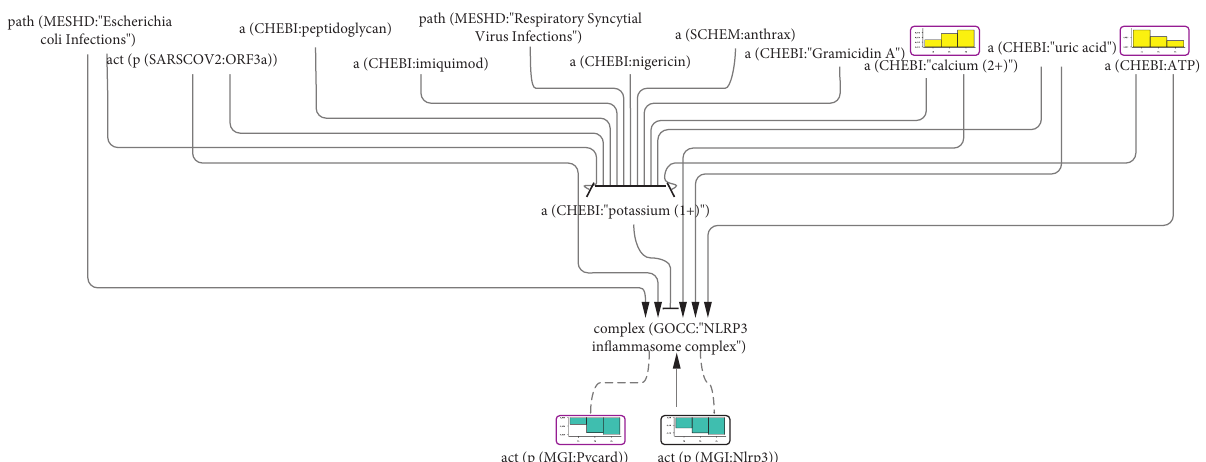
Figure 5: Part of the inflammasome network model scored with transcriptomic data from GSE11258. The bar graph above each node, which was scored, shows the inferred fold change in mouse hippocampus after (1) 1 hour, (2) 3 hours, and (3) 6 hours of 50mM KCl treatment. The directionalities are shown as yellow or blue bars for inferred upregulation or downregulation, respectively. The black outline refers to nodes that were significantly impacted at all time points, and the purple outline refers to nodes that were significantly impacted at two time